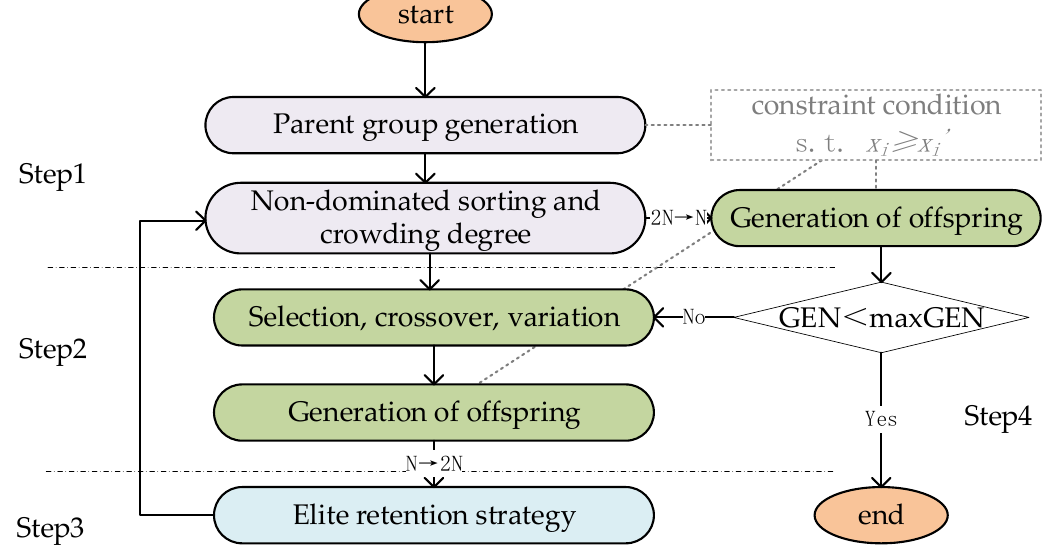
Figure 2. Framework of NSGAII. (NSGAII: non-dominated sorted genetic algorithm-II, GEN: genetic.)